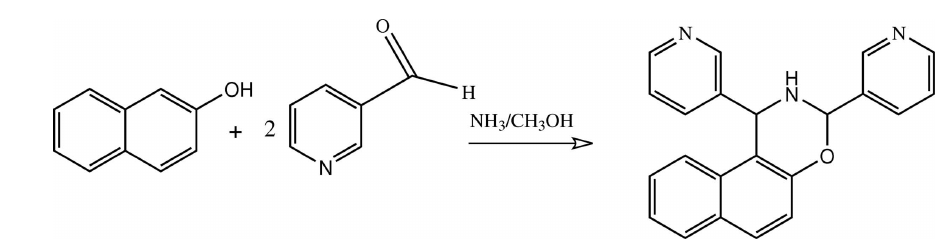
Figure 3 The formation of the title